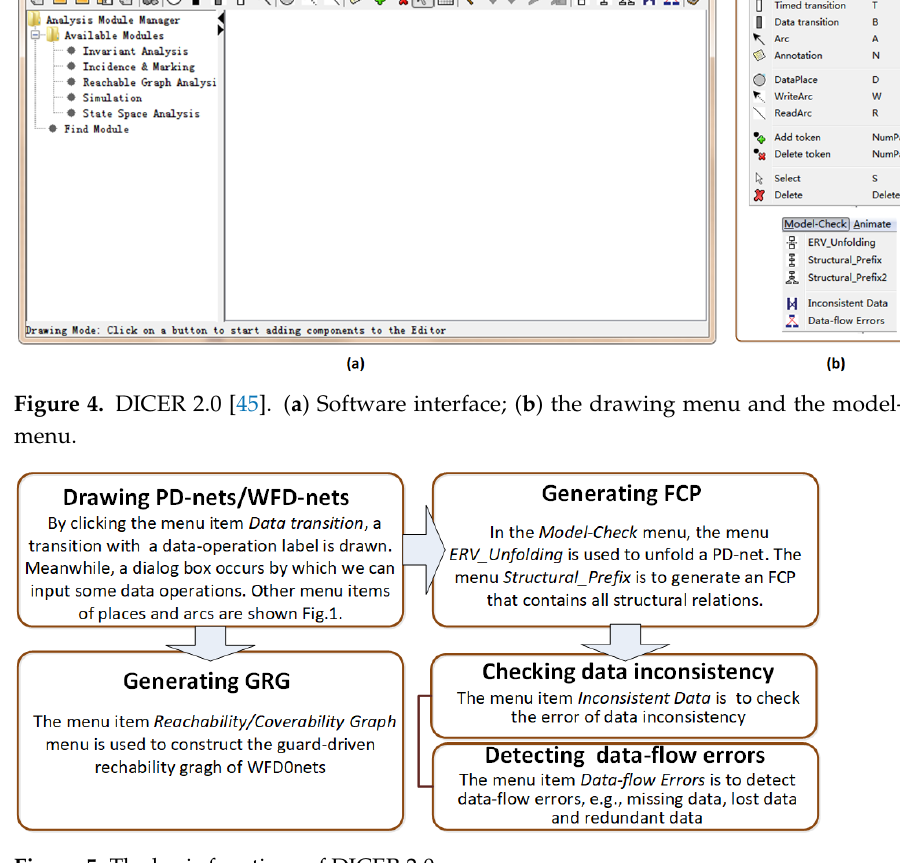
Figure 5. The basic functions of DICER 2.0.